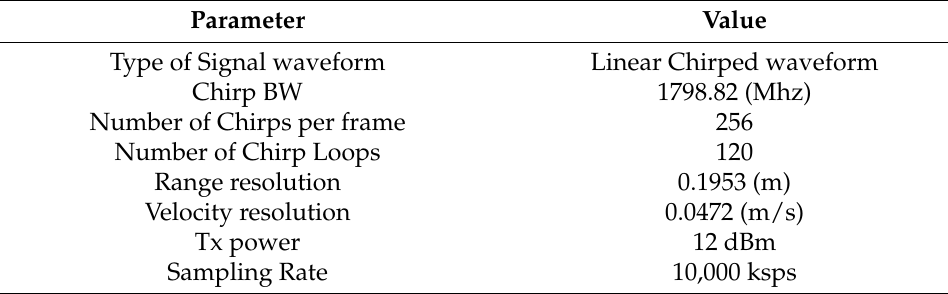
Table 1. FMCW experiment parameter